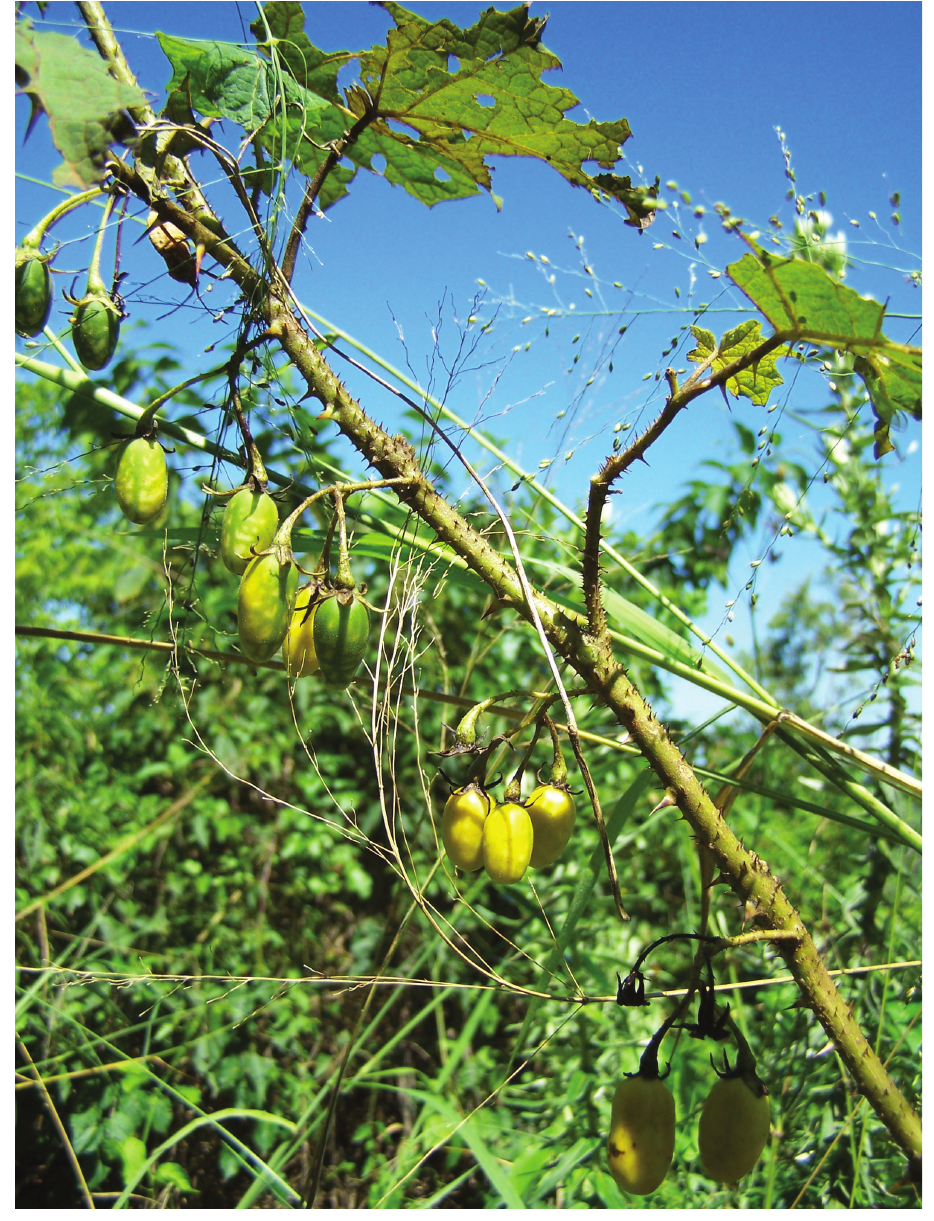
Figure 2. Fruiting branch of Solanum neei in Misiones, Argentina ( Keller 3922, CTES). vation concern. Applying the criteria of the IUCN (http://www.iucn.org/) suggests its conservation status should be ‘Least Concern’